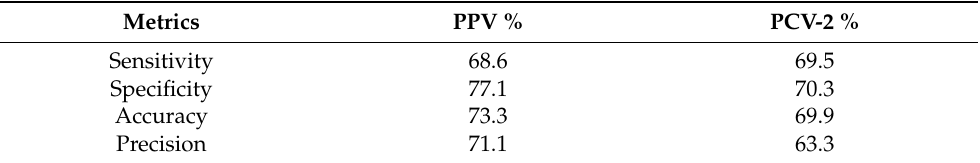
Table 6. Performance metrics summary of the novel POC device regarding the detection of porcine parcovirus and porcine circovirus 2.